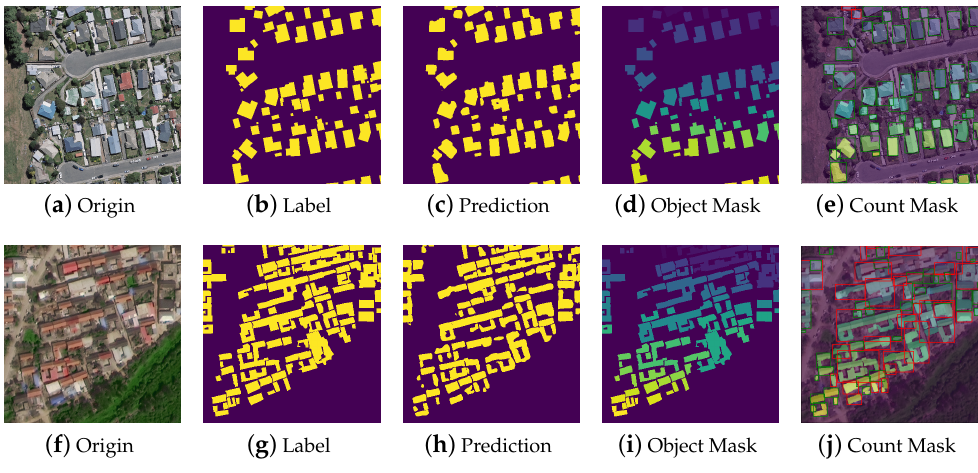
Figure 11. General situation results.